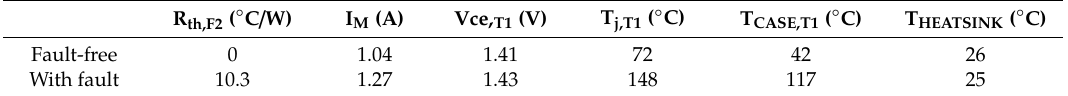
Table 1. In-circuit IGBT